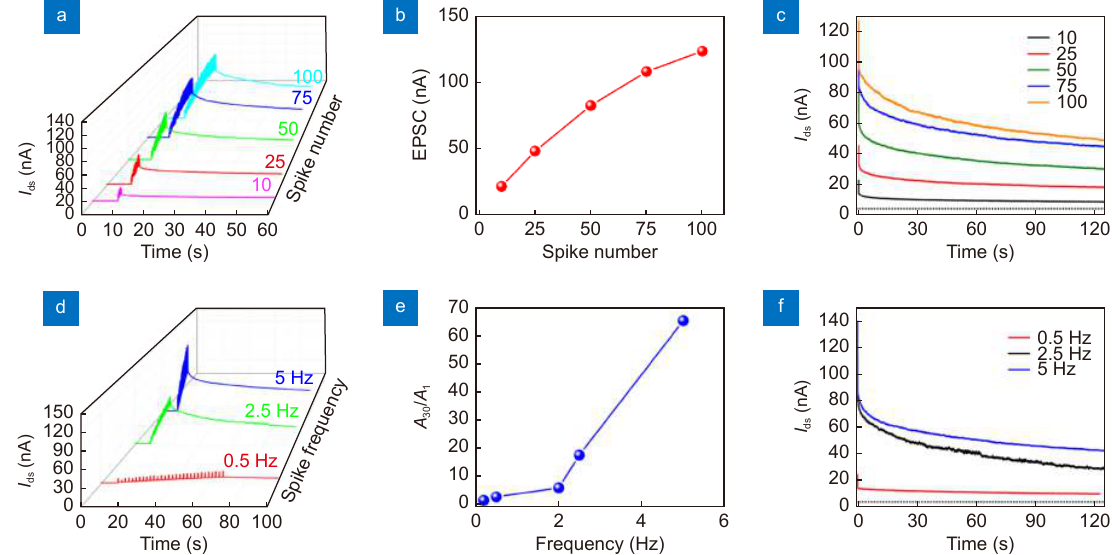
Fig. 4 | LTP characteristics of the MoS 2 synaptic transistor. The transient current ( a ), EPSC ( b ) and the extracted forgetting curve ( c ) from (a) after 10, 25, 50, 75 and 100 optical pulses. The transient current ( d ), A 30 / A 1 ( e ) and the extracted forgetting curve ( f ) from (d) triggered by differ- ent spike frequency where A 30 means the thirtieth EPSC. The black dashed line represents the initial current in (c) and (f) without optical